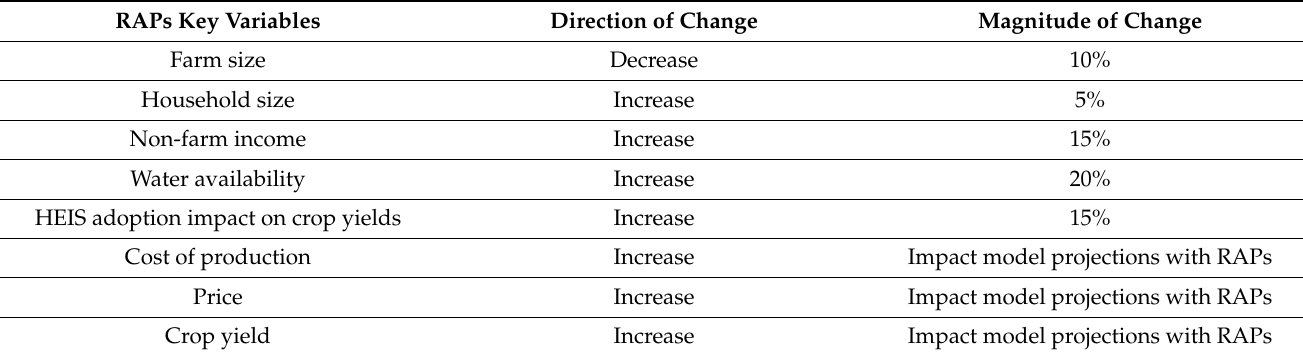
Table 1. Parameterization of RAPs for a sustainable agricultural production system. RAPs Key